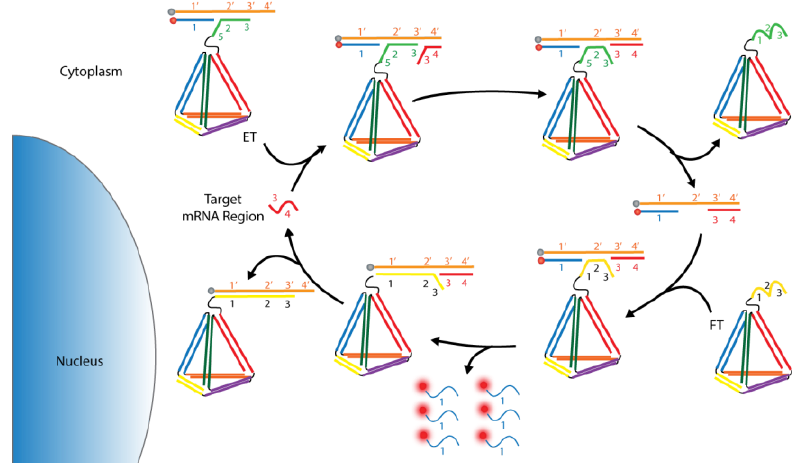
Figure 12. Schematic showing a 3D DNA nanomachine initiated by interaction with microRNA (analyte) leading to an amplified release of signaling molecules for intracellular detection. Adapted with permission from [396] Copyright 2018 American Chemical Society.